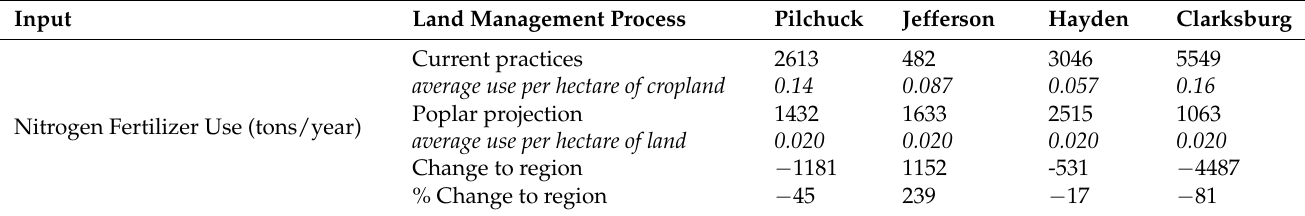
Figure 1. Areas where land could be converted to crowing poplar trees for bio-jet fuel. Each pixel is 8 × 8 km and contains at least one hectare of land than could be converted. The type of land converted in each pixel could be rangeland or cropland (irrigated and non-irrigated). Table 6. Fertilizer inputs per region. Average use of inputs per hectare of land for each region shown in